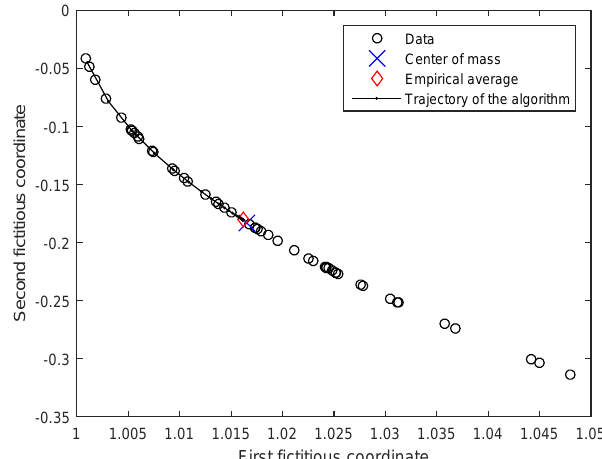
Figure 8. Minimization of the criterion function in Equation (38) over the pseudo-orthogonal group O ( 1,1 ) : Data set and result of mean-matrix computation.